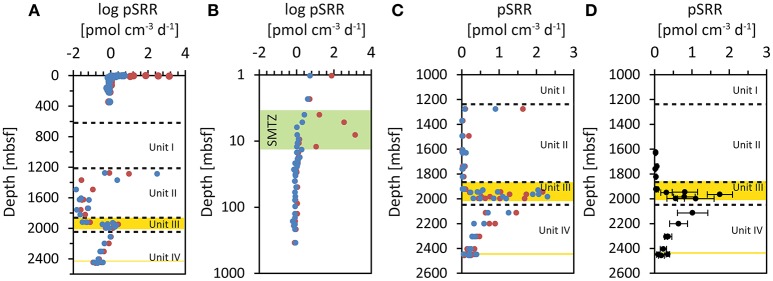
Potential sulfate reduction rates (pSRR) measured in incubations of sediment slurries at IODP Site C0020. Incubations with methane amended to the headspace are shown in red, incubations without methane amendment to the headspace are shown in blue. (A) Mean pSRR incubated with 35S labeled sulfate. (B) Mean pSRR in the upper 350 mbsf, incubated during CK06-06 (note the log depth scale). The green zone highlights the sulfate methane transition zone (SMTZ; (Kobayashi et al., 2008; Tomaru et al., 2009)). (C) pSRR of individual sample replicates from incubations during IODP Expedition 337 (note only pSRR values below 3 pmol cm−3 d−1 are plotted). (D) Mean pSRR of all replicates (with and without methane amendment) from incubations during the IODP Expedition 337 after conservative exclusion of potentially contaminated samples (see text). The error bars represent ± one standard deviation.